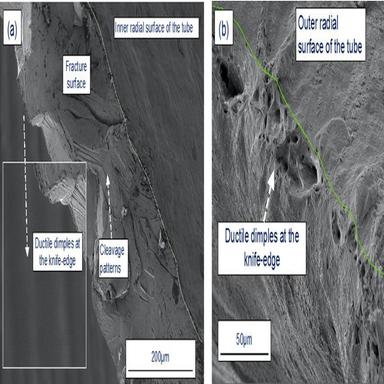
(a) Overview of the fracture surface of the burst specimen indicating the ductile dimples at the knife-edge and the cleavage patterns (Specimen # 12), (b) details of the fracture surface at the knife-edge rupture of the specimen #6.